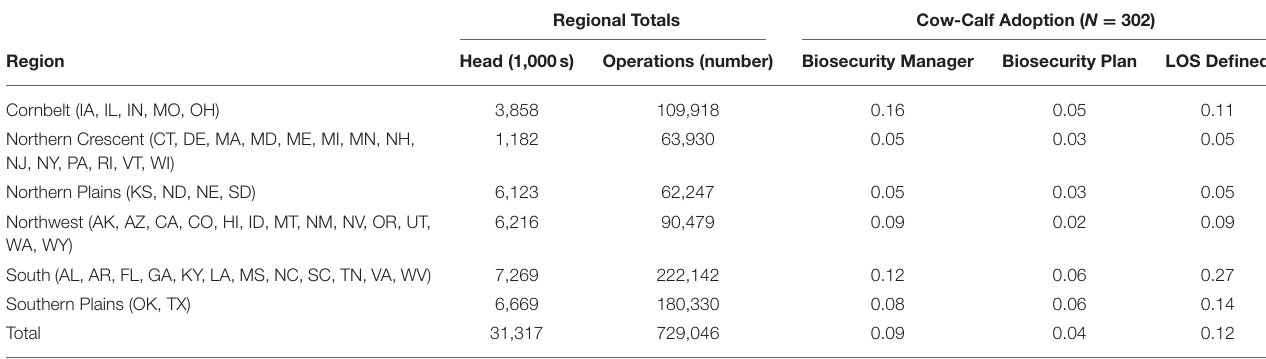
TABLE 3 | U.S. beef cow inventory, operations with beef cows, and pre-outbreak biosecurity practice adoption for cow-calf producers by region. Regional Totals Cow-Calf Adoption ( N = 302) Region Head (1,000s) Operations (number) Biosecurity Manager Biosecurity Plan LOS Defined